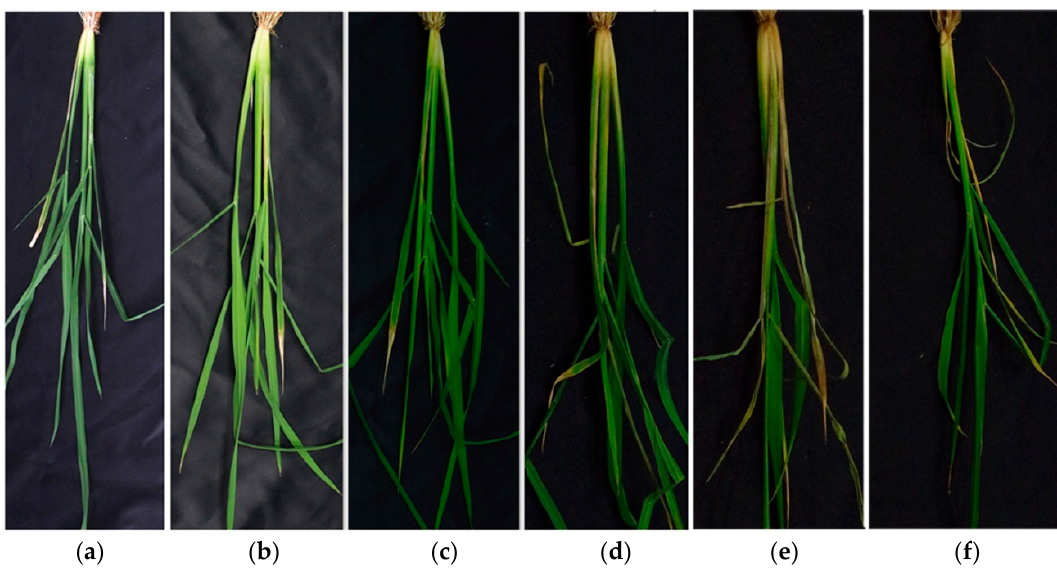
Figure 1. Samples of six degrees of infestation: ( a ) DI0; ( b ) DI1; ( c ) DI2; ( d ) DI3; ( e ) DI4; ( f ) DI5.